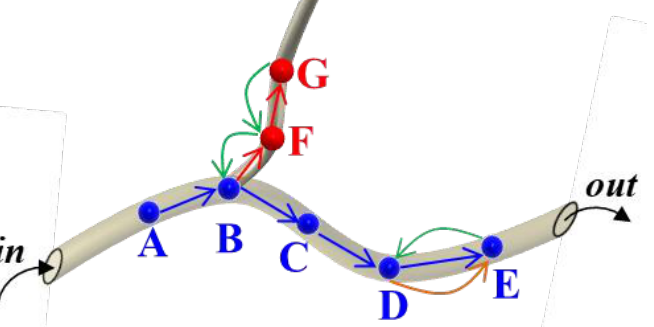
Figure 6. The schematic diagram of pest movement directions—“in” depicts the invasion hole, and “out” the feathering hole. Blue points indicate the points on the main gallery, and red points indicate points on the branching worm paths (i.e., new points created by pioneering movements). Blue arrows indicate forward movement, red arrows indicate pioneering movement, green arrows indicate backward movement, and orange arrows indicate forward movement paired with backward move- ment.